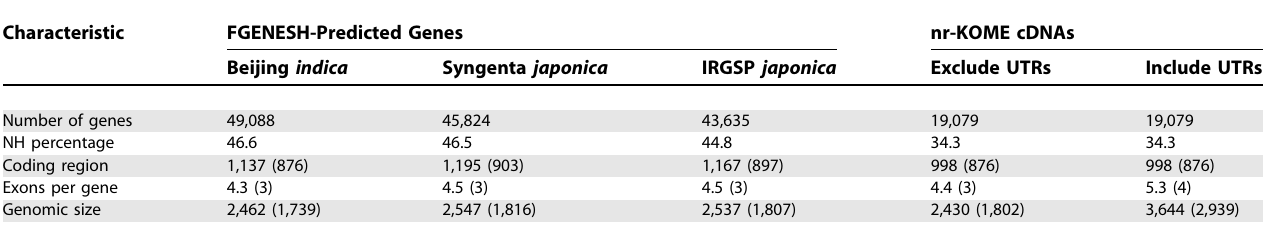
Table 4. Characteristics of FGENESH Predictions and nr-KOME cDNAs